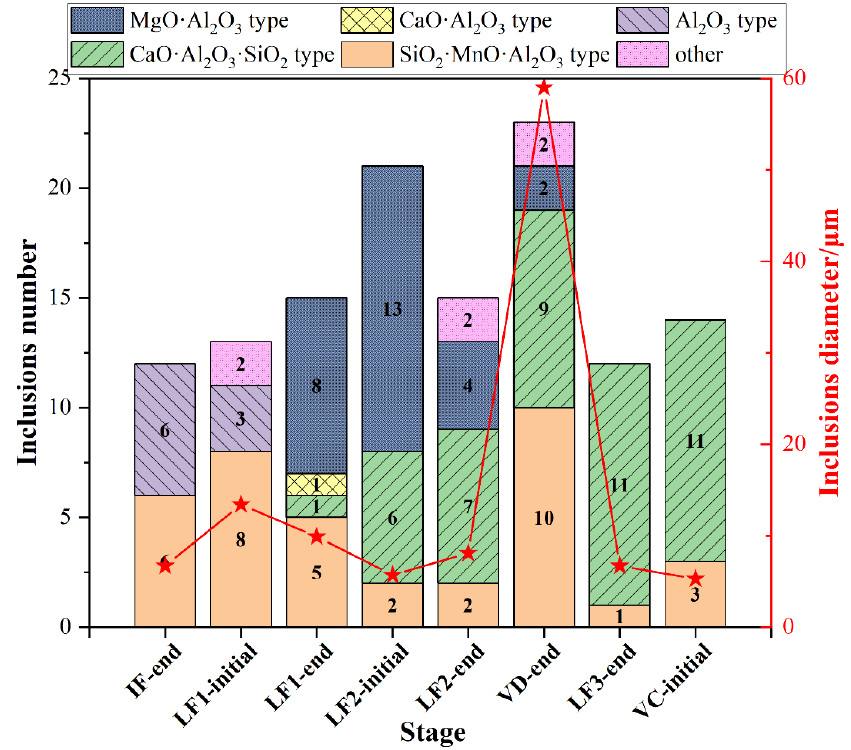
Figure 5. Type and average size distribution of all inclusions at different stages.